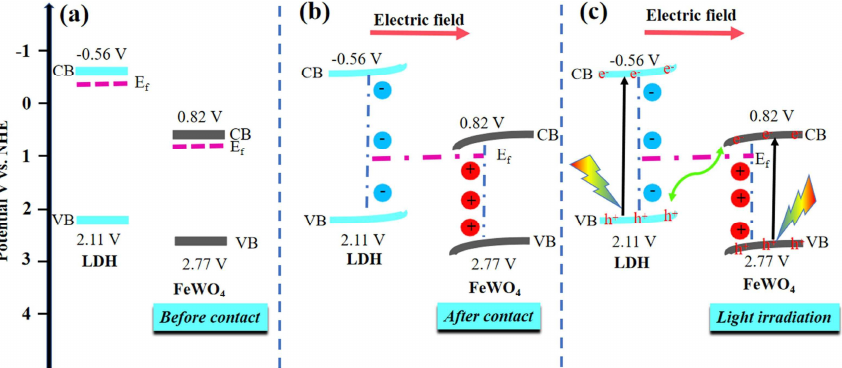
Figure 8. Photogenerated charges transfer pathway in FeWO 4 /NiAl−LDH heterostructure [93]. Cop- Figure 8. Schematic energy band diagrams of FeWO4 and NiAl − LDH ( a ) before and ( b ) after yright 2021 Elsevier. heterojunction formation. ( c ) Photogenerated charges transfer pathway in FeWO 4 /NiAl − LDH heterostructure under light irradiation [93]. Copyright 2021